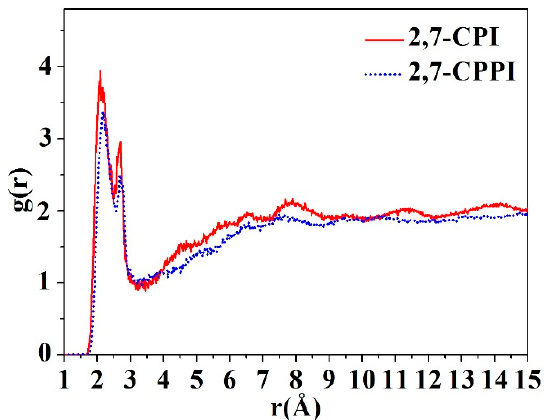
Figure 5. The RDFs of the hydrogen atoms of ‒ HN ‒ in carbazole and oxygen atoms of O=C ‒ in imide rings for 2,7 ‐ CPPI and 2,7 ‐ CPI.